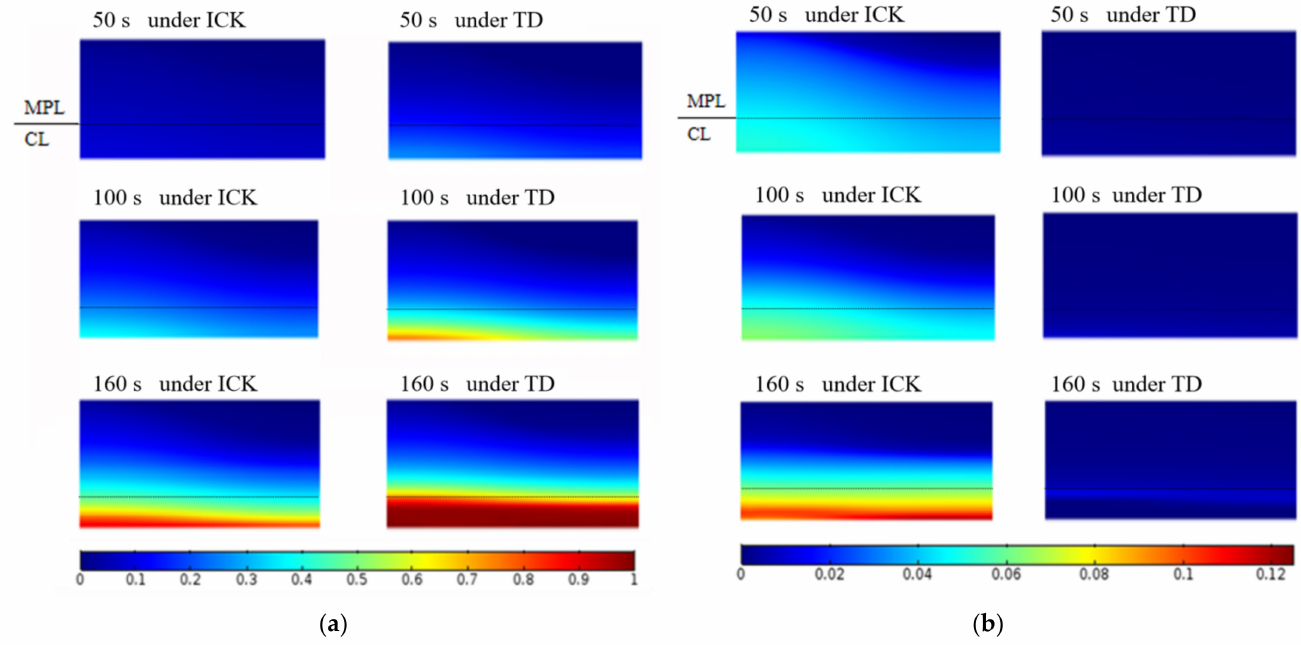
Figure 6. Distribution of liquid and ice in the cathode CL and MPL when started from − 20 ◦ C at 0.08 A/cm 2 under ICK and TD. ( a ) Distribution of ice saturation fraction; ( b ) Distribution of the liquid saturation